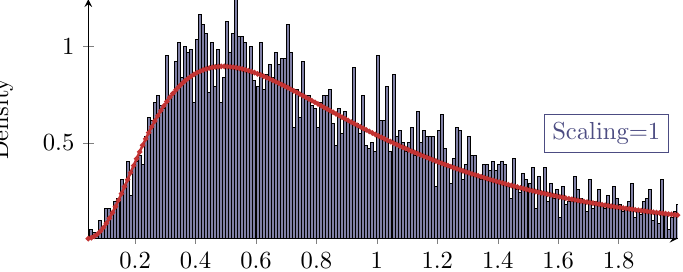
Figure 7. More detailed (finer) histogram of Figure 4 with scaling one from zero to two with a bin size of 0.01.